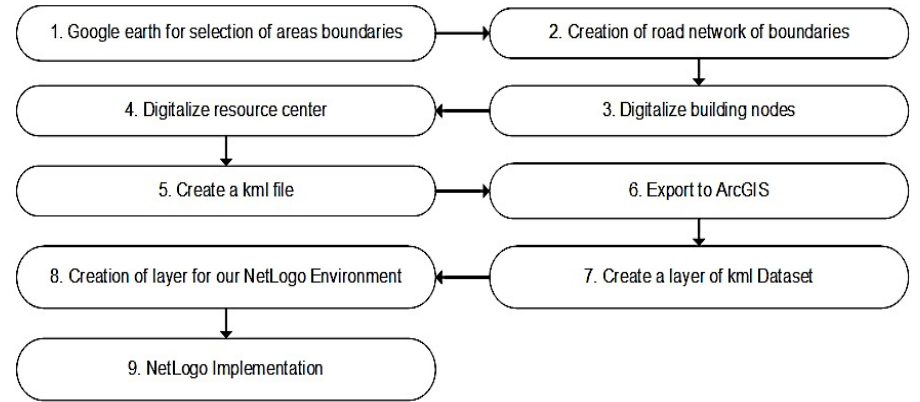
Figure 3. Steps for creation of scenario.